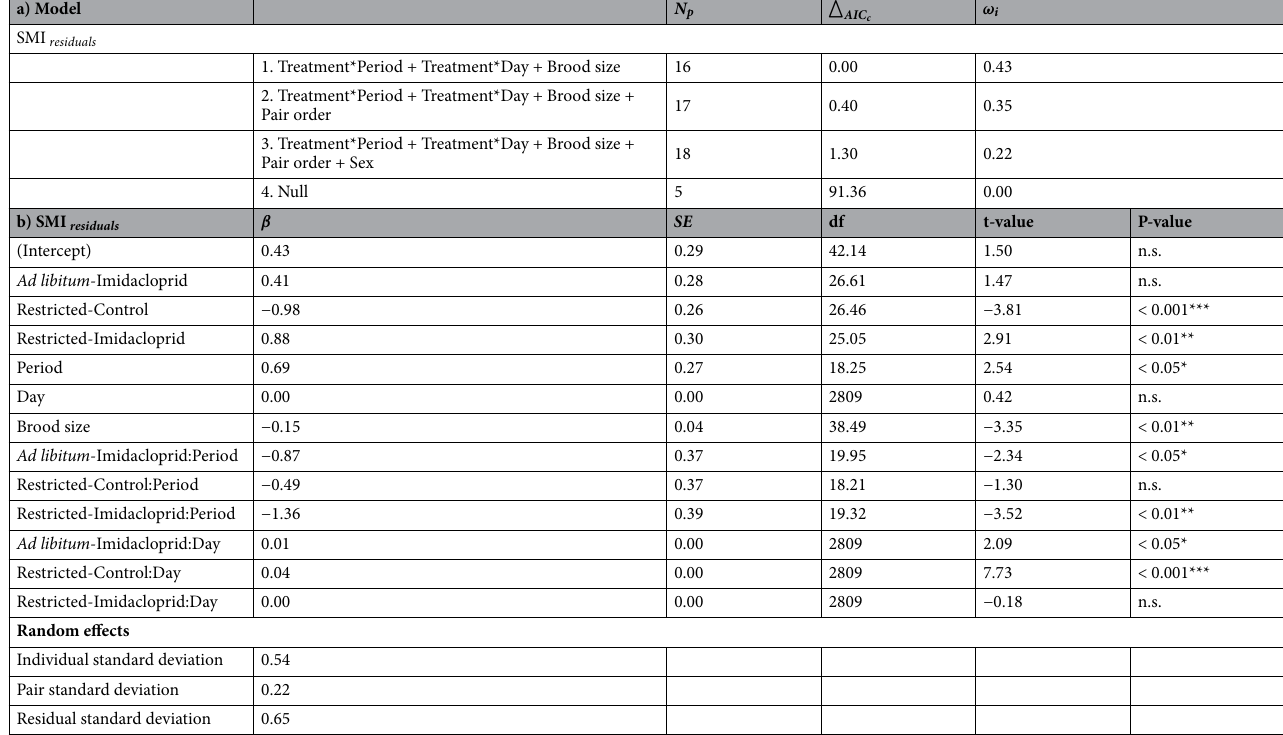
Table 1. ( a ) Model selection of the effects of treatments ( Ad libitum -Control, Ad libitum -Imidacloprid, Restricted-Control, Restricted-Imidacloprid), Sex, Brood size, Pair order) on scaled body condition residuals (SMI residuals ) from day 8 to day 30. ( b ) Parameter estimates (slopes [ β ] with standard error [ SE ], degrees of freedom [df], t-value and P-value) for top ranked model. Factor level references: Treatment = Ad libitum - Control, Period = First half-period. (N observations = 2937; from 129 individuals of 35 pairs used as random